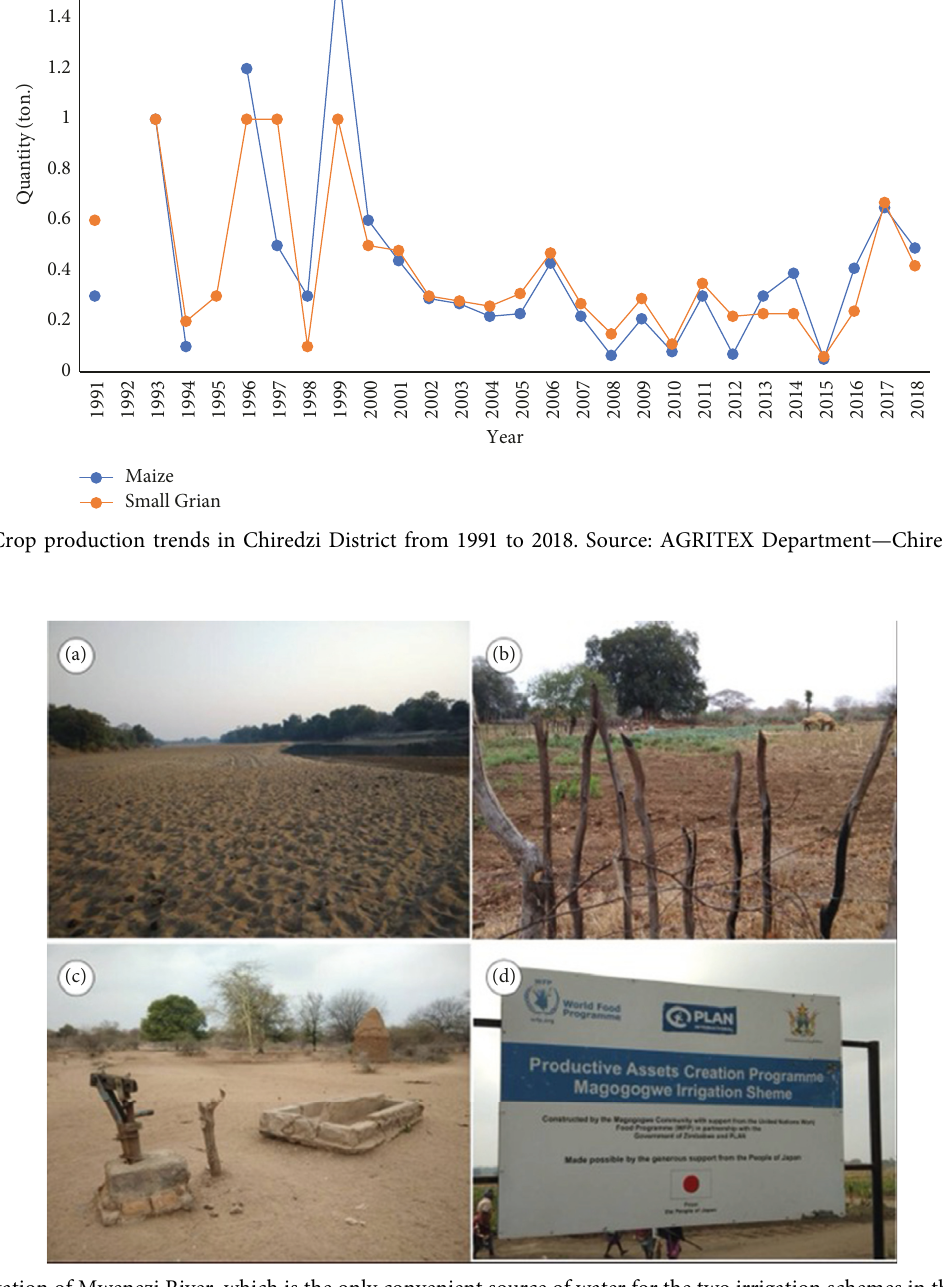
Figure 3: (a) Siltation of Mwenezi River, which is the only convenient source of water for the two irrigation schemes in the study area, (b) small garden sustained by a shallow well in Muhlekwani Village, (c) a defunct borehole in Ngwenyeni Village as the water table was reported to be very low due to climate change and variability, and (d) World Food Program project partnering communities in resuscitating an irrigation scheme. Photo credits: Joseph Antipas,